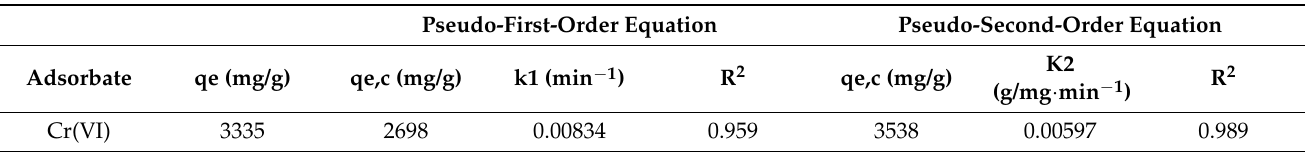
Figure 3. Adsorption kinetics analysis of Cr(VI) on MnFe 2 O 4 adsorbent: ( a ) Adsorption amount of Cr(VI) at various times; ( b ) fitting line of the pseudo − first − order equation; ( c ) fitting line of the pseudo-second-order equation. Table 1. Kinetic fitting parameters for the pseudo-first-order and pseudo-second-order equations for Cr(VI) adsorption onto the MnFe 2 O 4 adsorbent.